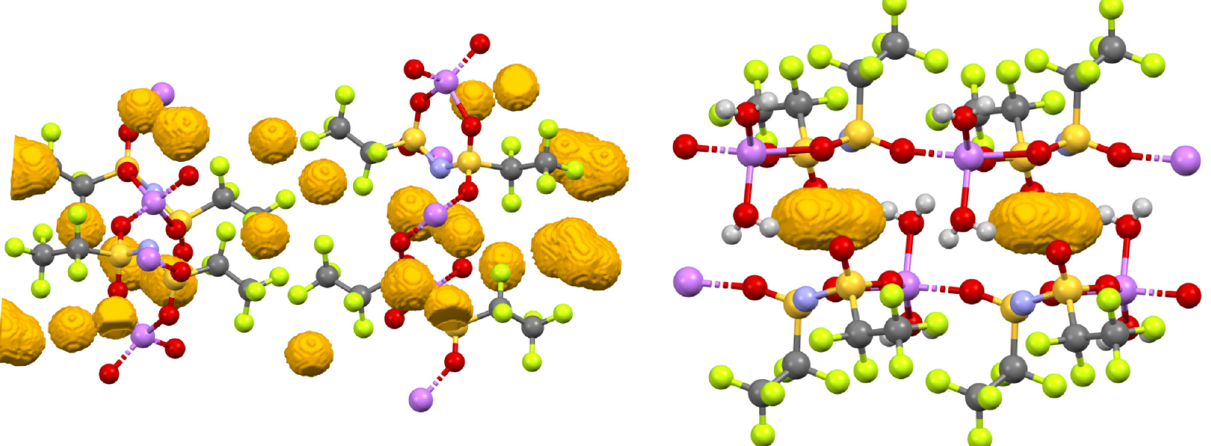
Figure 5. Visualization of the void space (yellow spheres) in [Li{BETI}] ( left ) and [Li{BETI}(H 2 O) 2 ] ( right ).